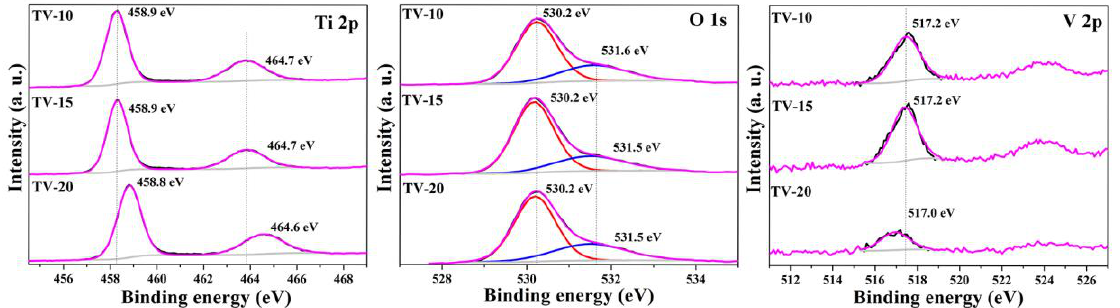
Figure 2. Cross-section of TiO 2 nanotube arrays for samples: ( a ) T-10, ( b )T-15, ( c )T-20 ( d ) TV-10, ( e ) TV-15, ( f ) TV-20.